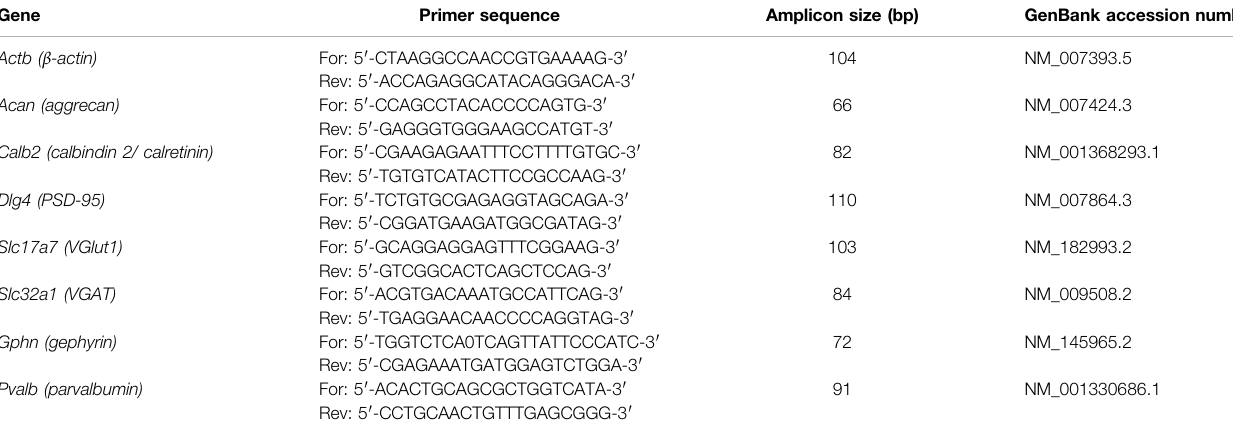
TABLE 2 | Primer sequences for RT-qPCR. bp = base pairs, for = forward, rev = reverse.